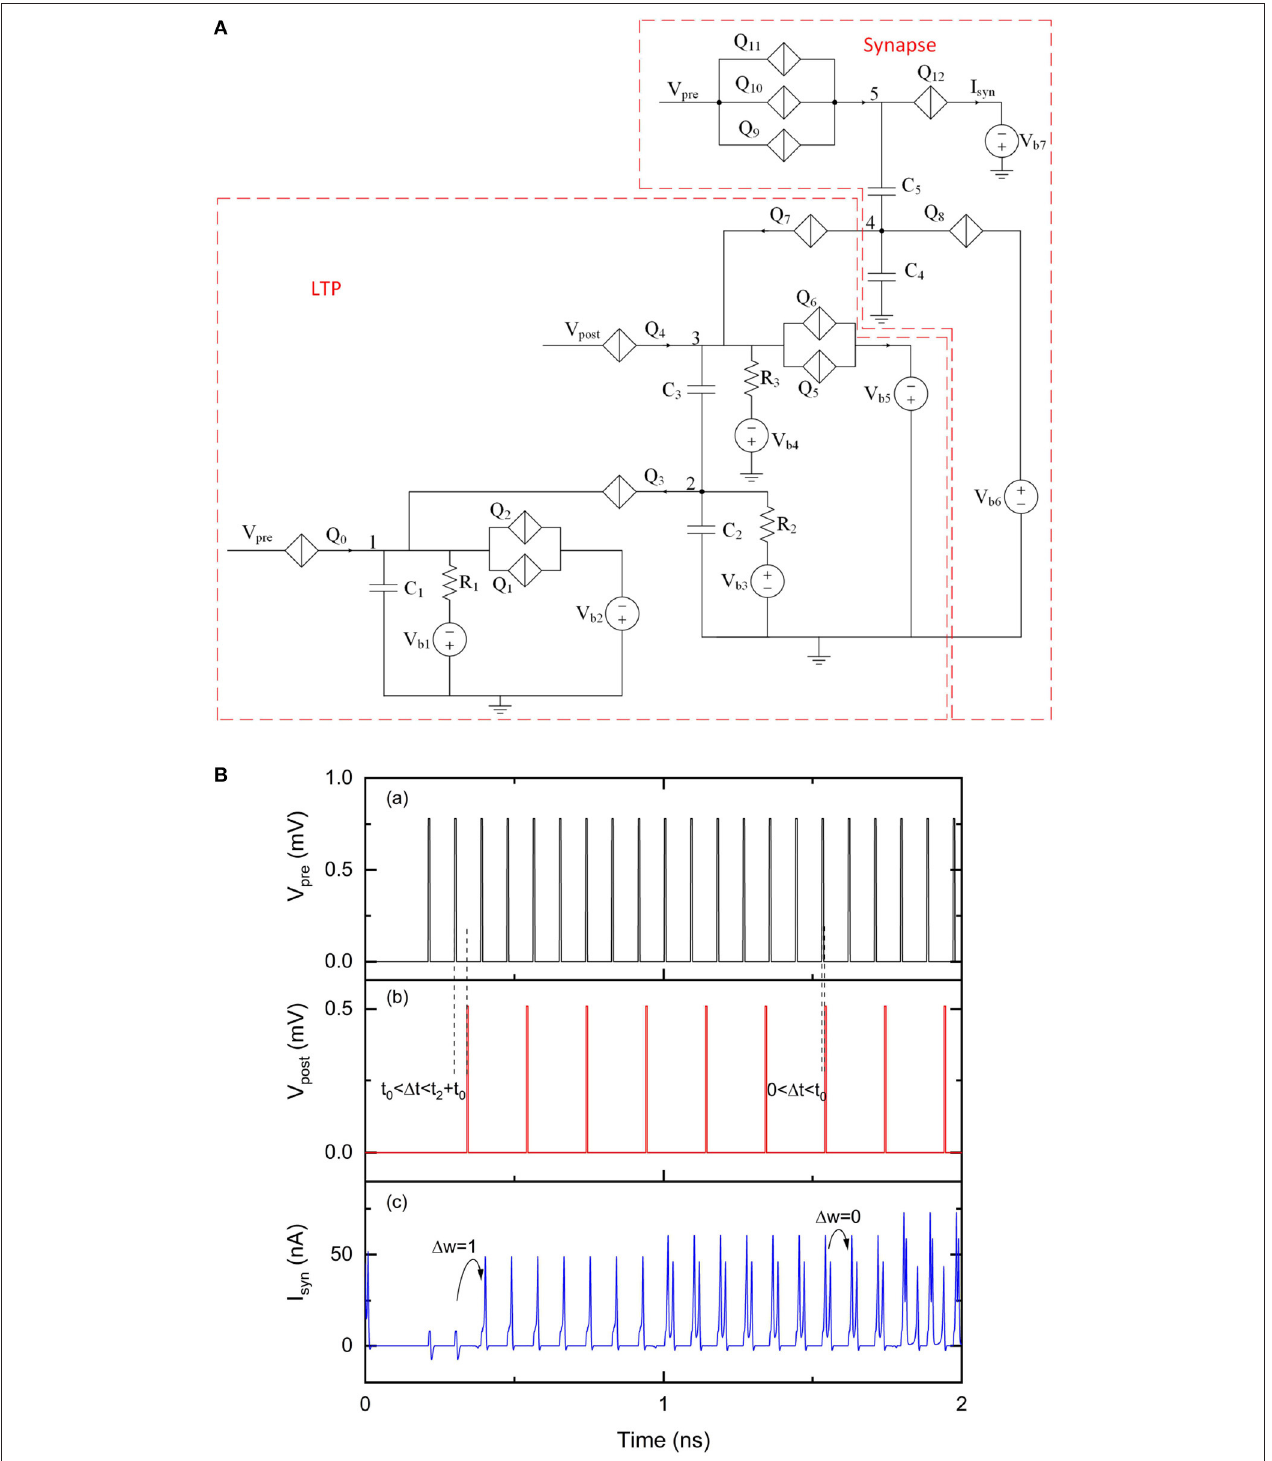
FIGURE 8 | A modified LTP circuit with a multi-weight synaptic circuit. The number of sequential current pulses at I syn can be increased when the timings of pulses from V pre and V post trigger an LTP learning event. V pre was 0.78 mV and V post was 0.51 mV. The critical voltage values used for Q 0 – Q 12 were 0.8, 0.95, 0.95, 0.36, 0.5, 1, 1, 0.58, 2, 1.04, 1.02, 1, and 0.28 mV, respectively. C 1 , C 2 , C 3 , C 4 , and C 5 were 1, 9, 1, 9.2, and 2, respectively. V b1 , V b2 , V b3 , V b4 , V b5 , V b6 , and V b7 were 0.2, 1.1, 0.05, 0.2, 1.1, 1.01, and 0.6 mV, respectively. R 1 , R 2 , and R 3 were 10 k (cid:127) . (A) Circuit schematic. (B) Simulation results. (a) Input signal V pre . (b) Input signal V post . (c) Output signal I syn